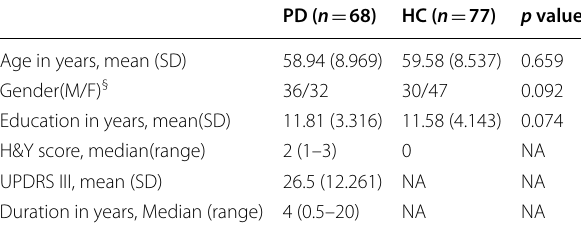
Table 1 Demographic and clinical assessments of